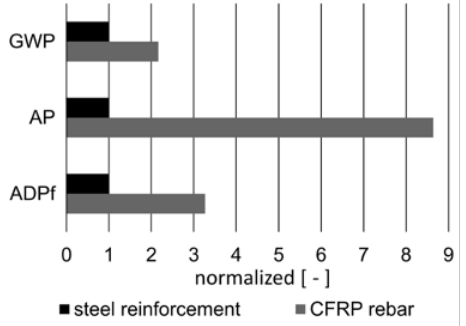
Figure 6. Comparison of steel and CFRP reinforce- ment per kg product system as well as per MPa tensile respectively yield strength (normalized values).